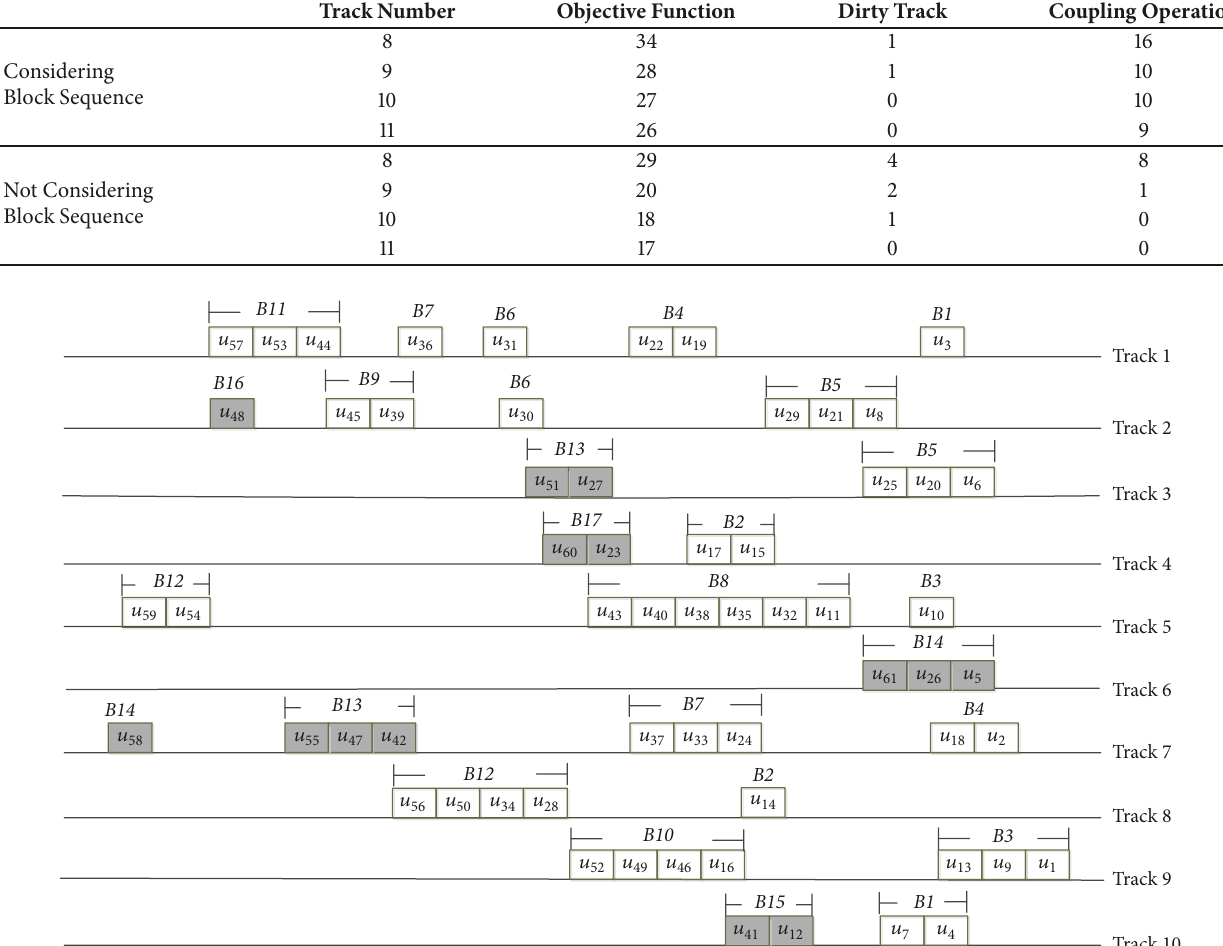
Figure 6: Track assignment with 10 tracks (with block sequence